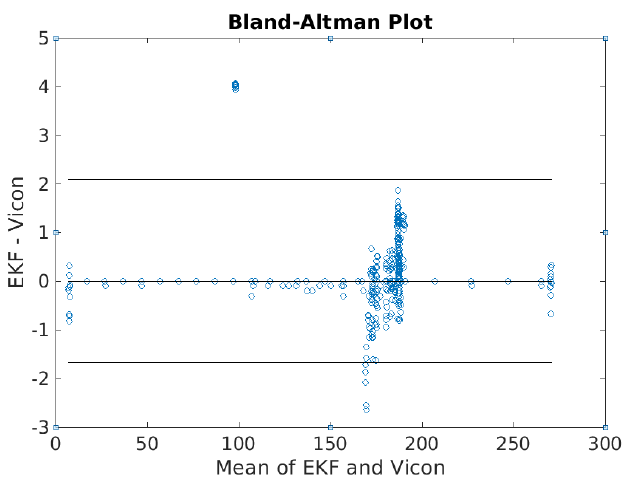
Figure 6. Bland–Altman plot of heading results ψ ( ◦ ) derived from attitude EKF2. The max error (6 ° ) in the heading is caused by the errors in the gravity measurements used in Kalman filtering and the cross-axis sensitivity of the inertial sensors. A small error in the gravity measurements has a significant impact on the heading. The errors in the heading are coupled into pitch and roll because of the sensor cross-axis sensitivity. This increases the errors in the gravity measurements due to the deteriorated pitch and roll solutions. The Bland–Altman plot of pitch and roll angles obtained from the attitude EKF2 pre- sented in Figure 8 shows the average errors of 0.7 ° in both. Compared with the fine align- ment process, the attitude EKF2 reaches the same accuracy in estimating pitch and roll under dynamic conditions. The errors caused by the rotations introduced during the test- ing are not exactly about the sensor axes; as a result, the rotation along one axis is projected into the other two axes. Moreover, the EKF2-derived attitude is noisier compared to the reference because the EKF2 is tuned to have a wide bandwidth and thus a quick dynamic response. Figure 7. The initial transients of heading estimates in EKF2. 0